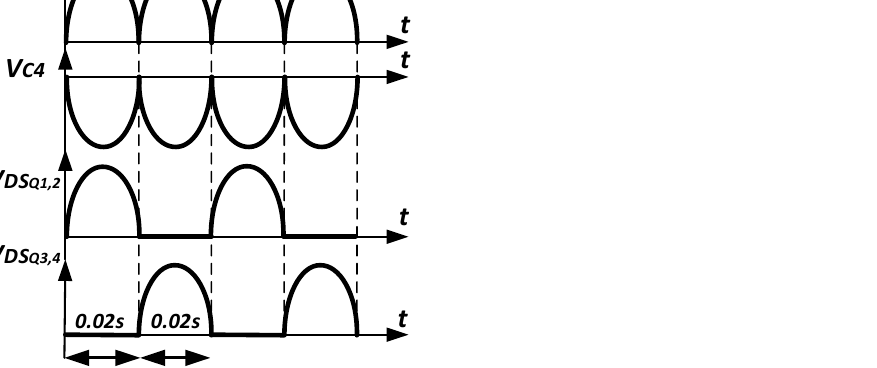
Figure 8. Voltage states across the capacitors of the QZSI and drain-source pins of the FBI switches. Voltage across capacitors C3 and C4 can be obtained by: